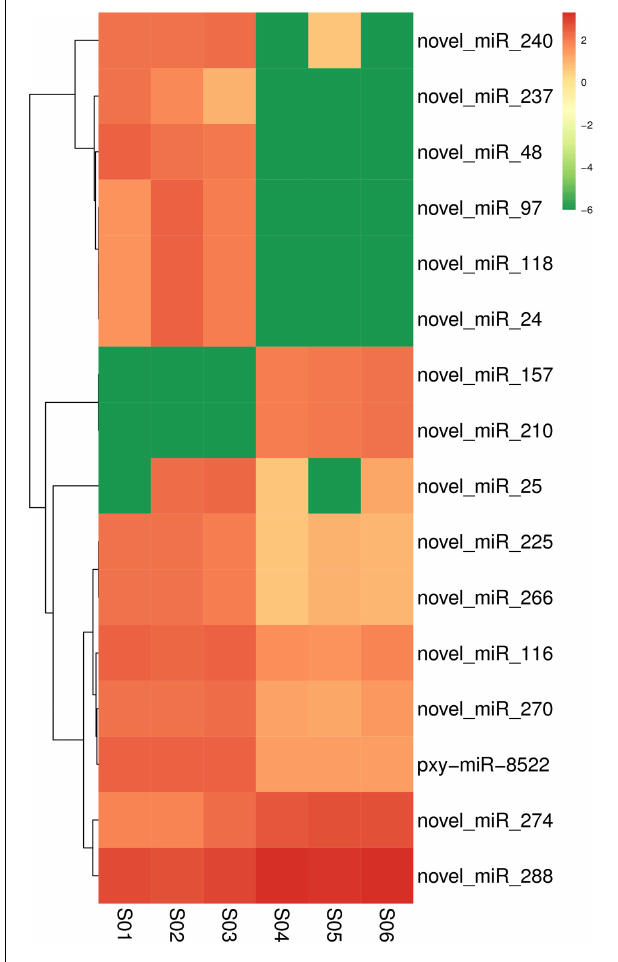
FIGURE 4 | Cluster analysis diagram showing the differentially expressed miRNAs in the resistant (Cry1S1000) and susceptible (G88) strains. Clustering was performed with log 10 (TPM + 1E-6) values. Samples of the G88 strain, S01–S03; samples of the Cry1S1000 strain, S04–S06. Columns represent different samples, while rows indicate different miRNAs. Red blocks represent the higher expressed miRNAs, green blocks represent the lower expressed